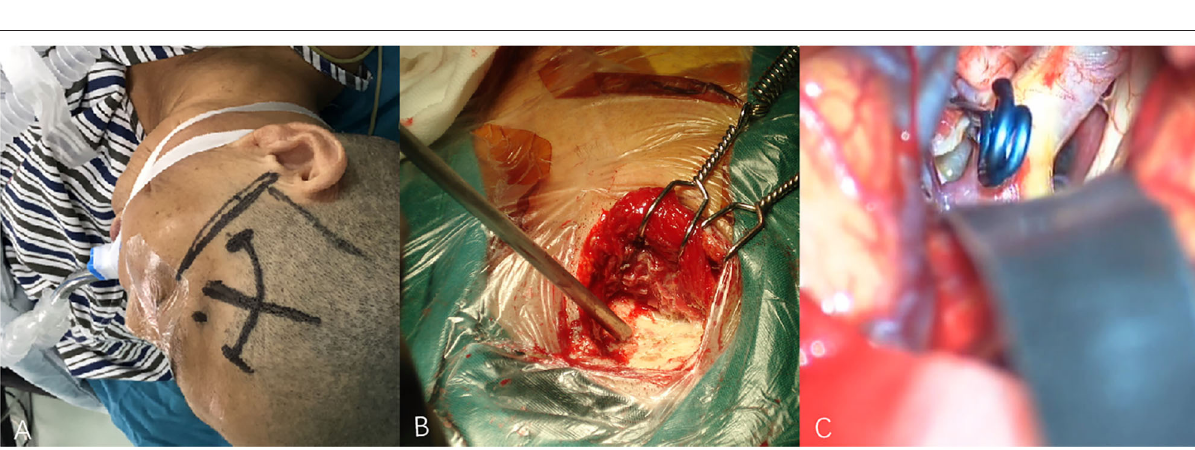
most patients after SKA surgery have excellent aesthetic